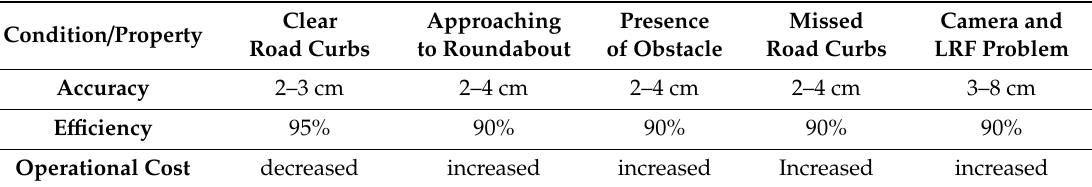
Table 2. An average of the accuracy, e ffi ciency, and operational cost of the autonomous vehicle when it is passing through a roundabout (with 5 m as